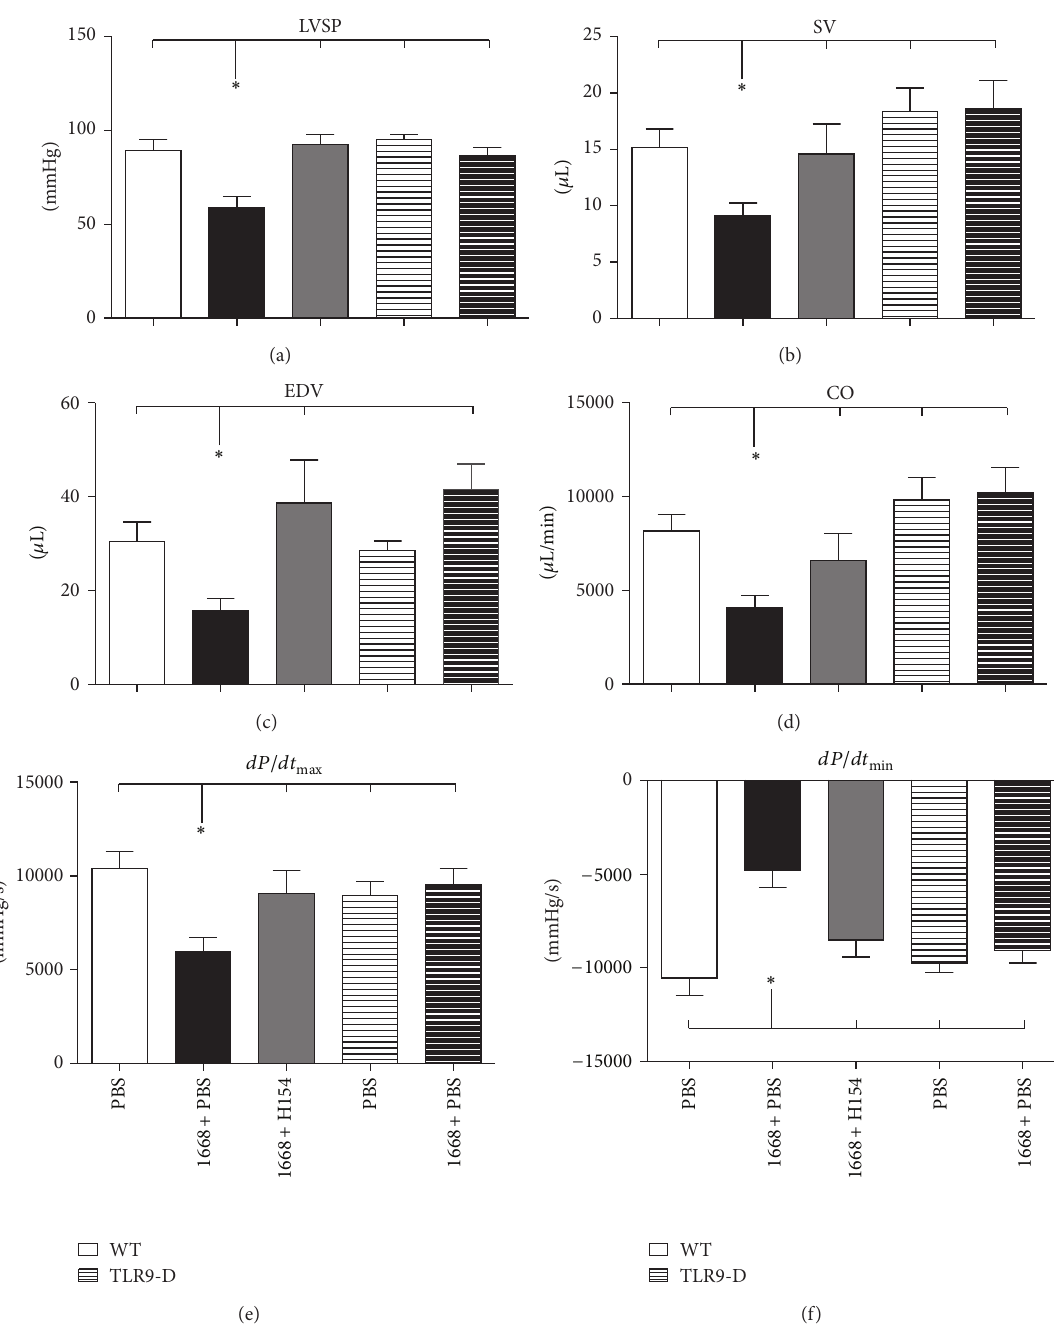
Figure 4: (a)–(f) Hemodynamic parameters, (a) left ventricular systolic pressure (LVSP), (b) stroke volume (SV), (c) end-diastolic volume (EDV), (d) cardiac output (CO), (e) velocity of pressure increase (dP / dt max ), and (f) velocity of pressure decrease (dP / dt min ) monitored with a pressure-volume catheter 6 h after stimulation with the TLR9 agonist 1668-thioate. Bars of TLR9-D are striated (mean ± SEM; 𝑛 = 8 /group, ∗ 𝑃 < 0.05 ; ∗ also indicates the significant group).